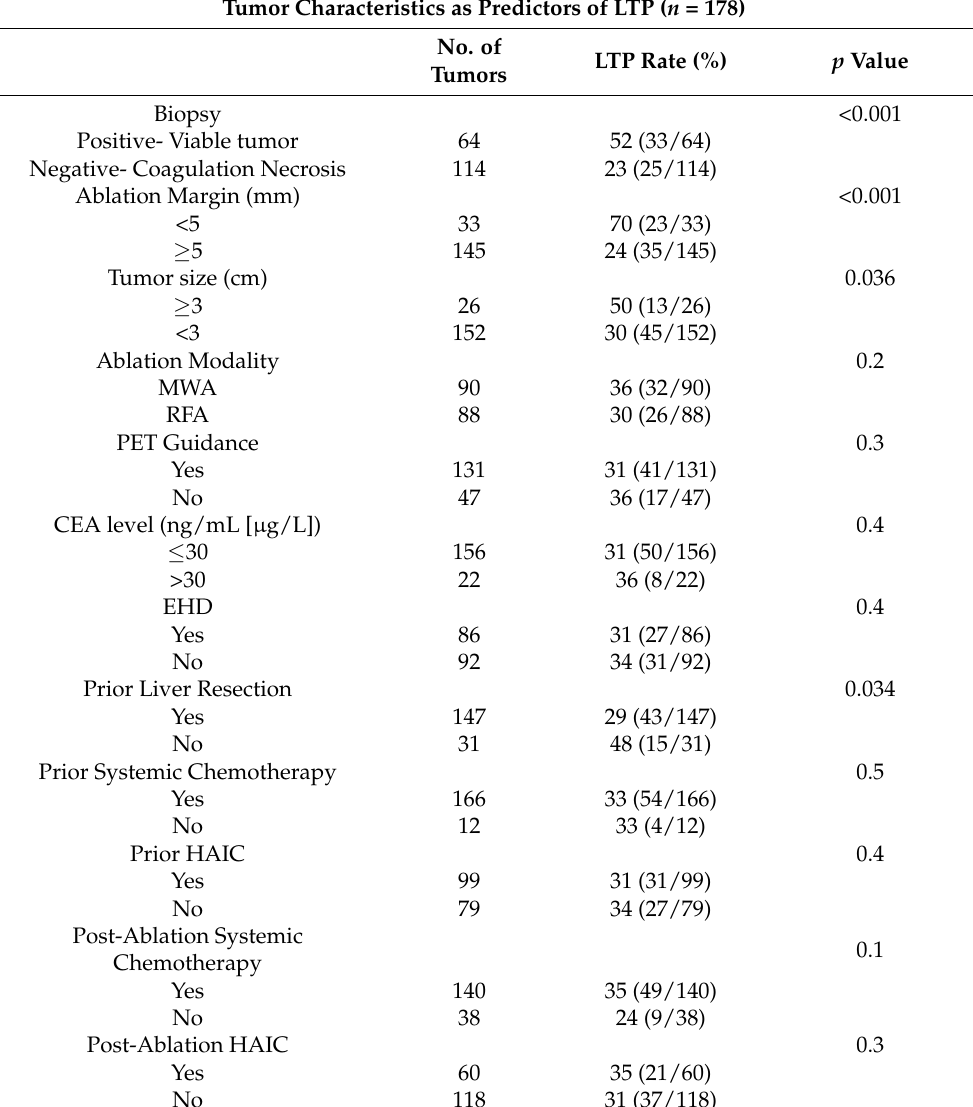
Table 2. Tumor characteristics as predictors of local tumor progression (LTP). Tumor Characteristics as Predictors of LTP ( n =